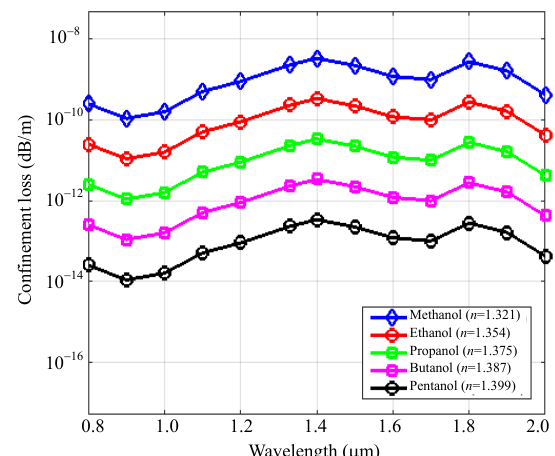
Fig. 5 Comparison of the confinement loss with alcohol series for two-layer core.